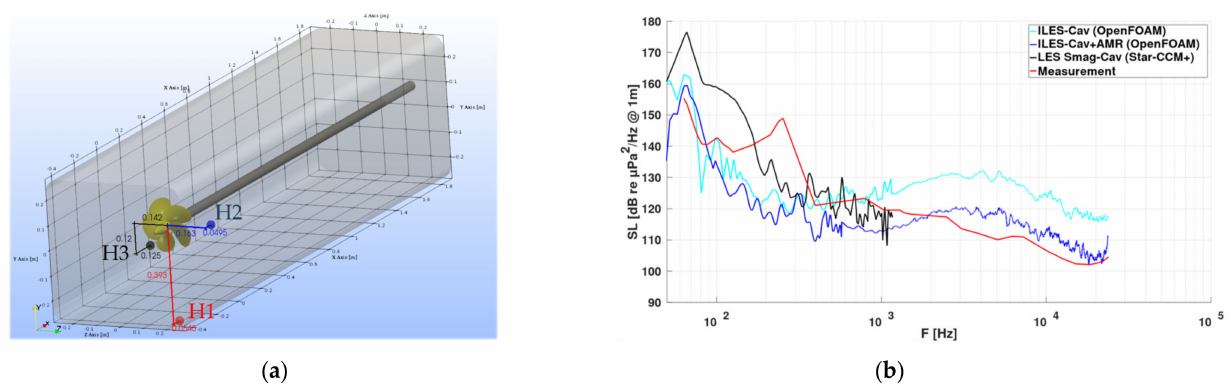
Figure 4. Newcastle. Acoustic investigation: ( a ) numerical setup with pressure observers H1-H3; ( b ) comparison of the SL for different solvers with the averaged measurement, condition C1, observer H2.